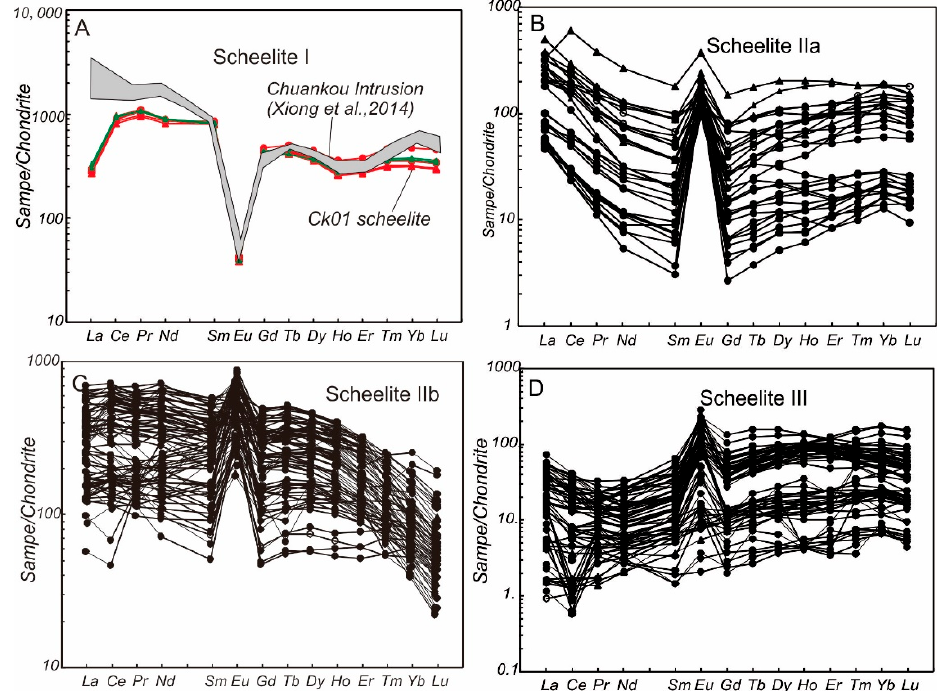
Figure 7. Chondrite-normalized REE patters of different types of scheelites from the Chuankou tungsten deposit. ( A ) scheelite from the top of the Chuankou intrusion; ( B ) scheelite from sandstone; ( C ) scheelite from the boundary between sandstone and slate; ( D ) scheelite from slate. Chondrite values are from Sun and McDonough [39].